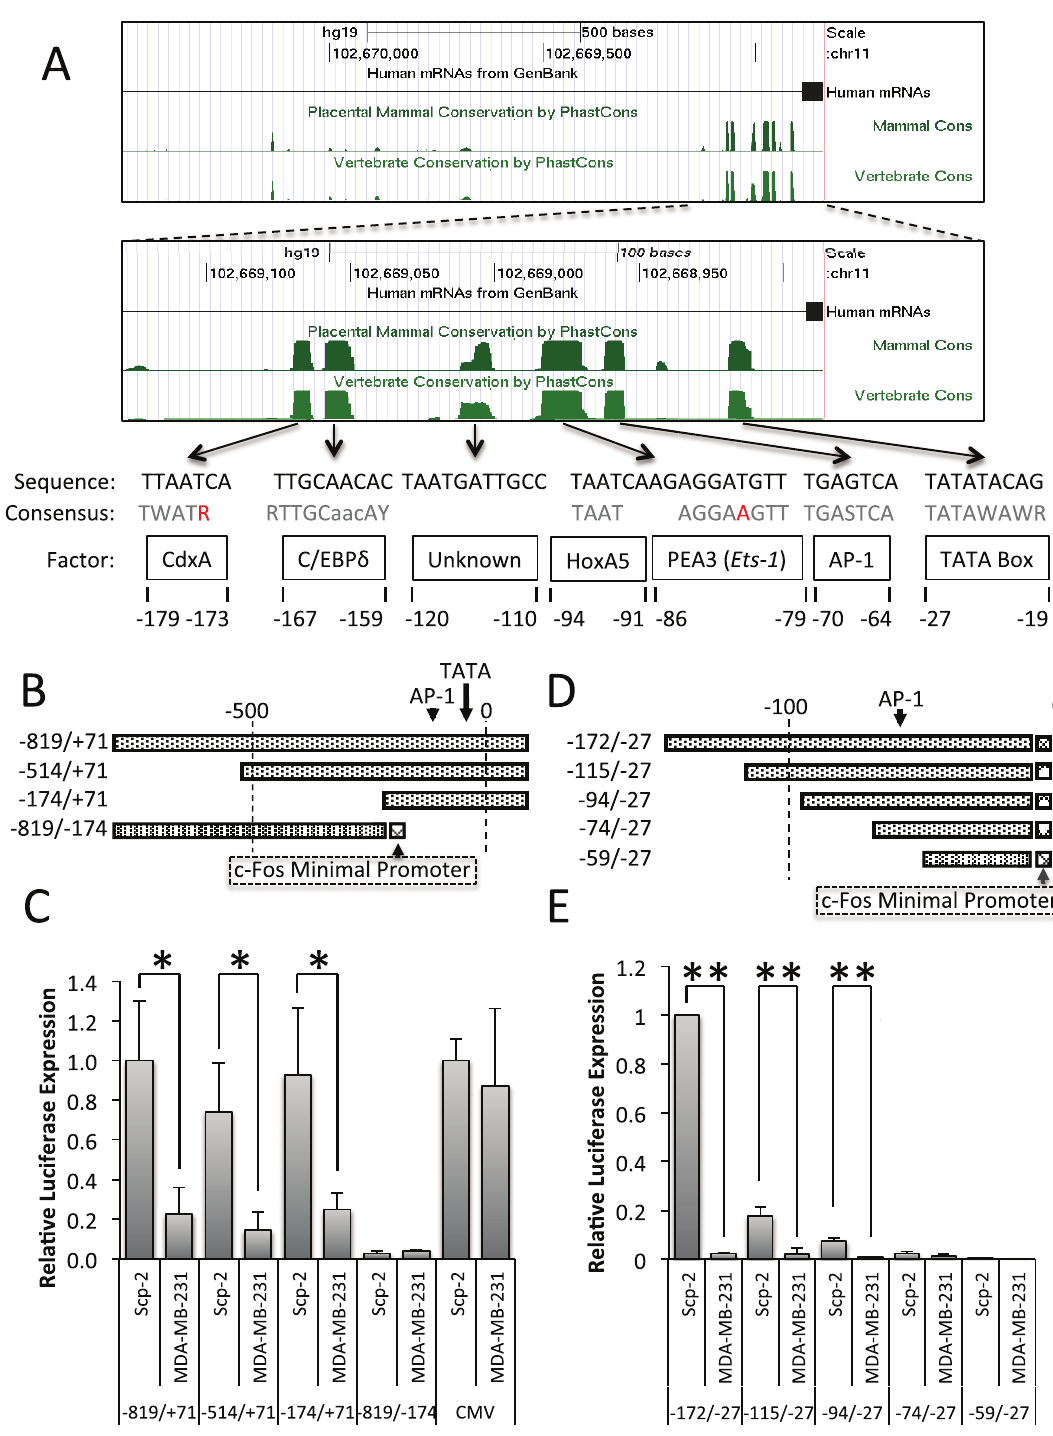
Figure 2. Regulatory regions and elements in the MMP1 promoter. A ) Genome Browser analysis of placental mammalian and vertebrate conservation by PhastCon 26 . Regions of conservation were compared to known transcription factor consensus sequences (shown in gray, with unmatched bases in red); numbers represent base position in reference to MMP-1’s transcription start site. B , D ) Schematic of MMP-1 reporter constructs. C , E ) Luciferase signal from Scp-2 and MDA-MB-231 cells transfected with the indicated reporter constructs. The signal was normalized to the Renilla luciferase levels from the co-transfected pRL-SV40P plasmid. The pCMV-luciferase construct was included as a control and its values were normalized to 1.0 for the Scp-2 cells. Its expression was approximately 10 times stronger than the MMP-1 -819/+71 luciferase reporter. The data shown represent the mean +/- standard deviation from three independent experiments. *, p < 0.05 for two-tailed